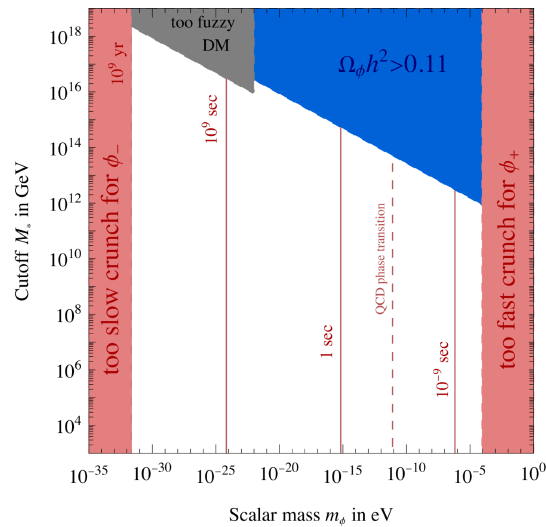
Figure 7 . Parameter space of the mechanism, assuming the same mass for both scalars. The red lines denote the maximal crunching time of patches with the “wrong” value of the weak scale. Red- shaded regions are excluded either because the crunching time is cosmologically long or because crunching would occur before the Electroweak phase transition. In the blue region oscillations of the scalars produce too much dark matter, at its boundary the cosmological DM abundance is reproduced. In the gray region the DM mass is larger than astrophysical lower bounds